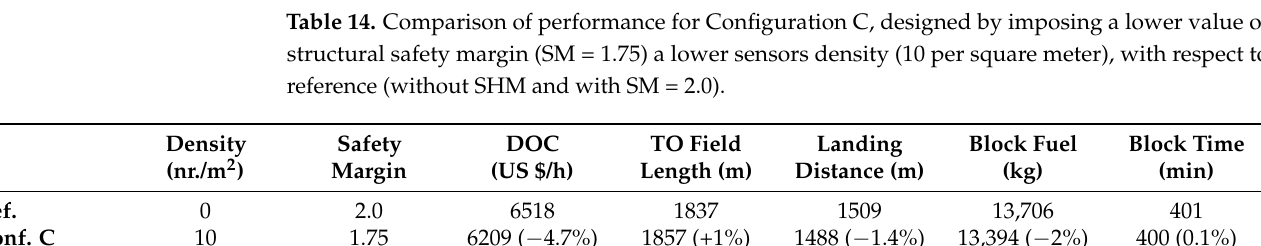
Table 14. Comparison of performance for Configuration C, designed by imposing a lower value of